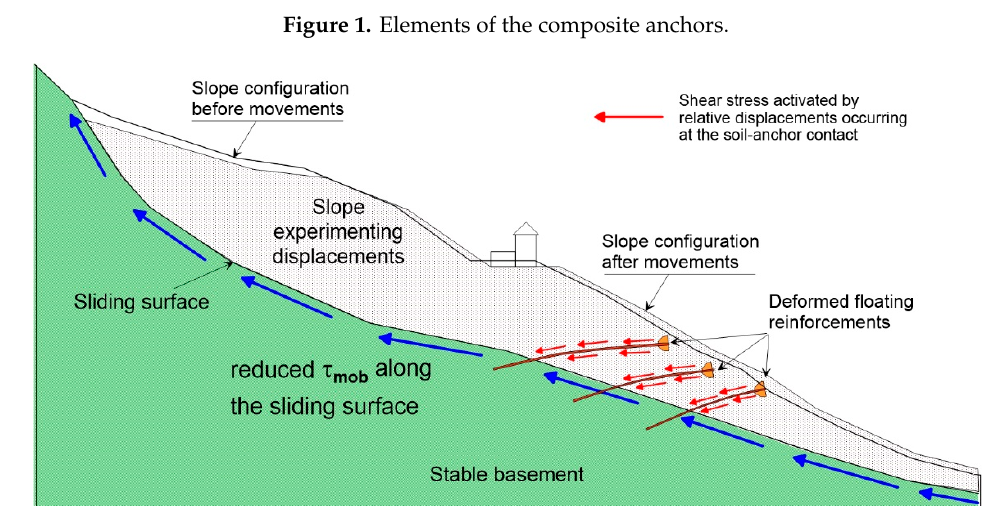
Figure 2. Working schemes of the “floating anchor” technique with composite bars and external slab [6].